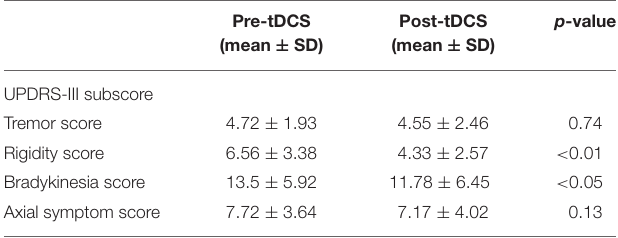
TABLE 2 | Comparison of mean UPDRS-III subscores in total PD subjects before and after tDCS application.